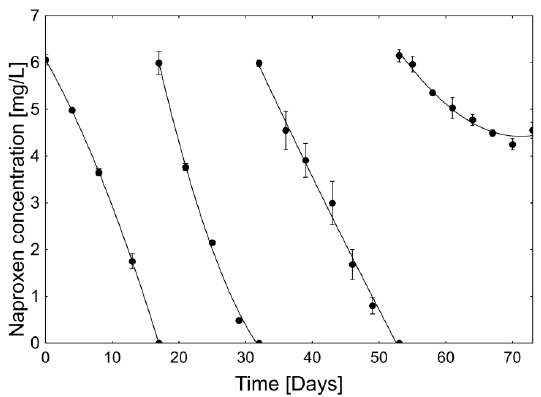
Figure 4. Cycles of 6 mg/L naproxen degradation by immobilized Planococcus sp. S5 on the loofah sponge. Data presented as a mean ± standard deviation of three re plicates.